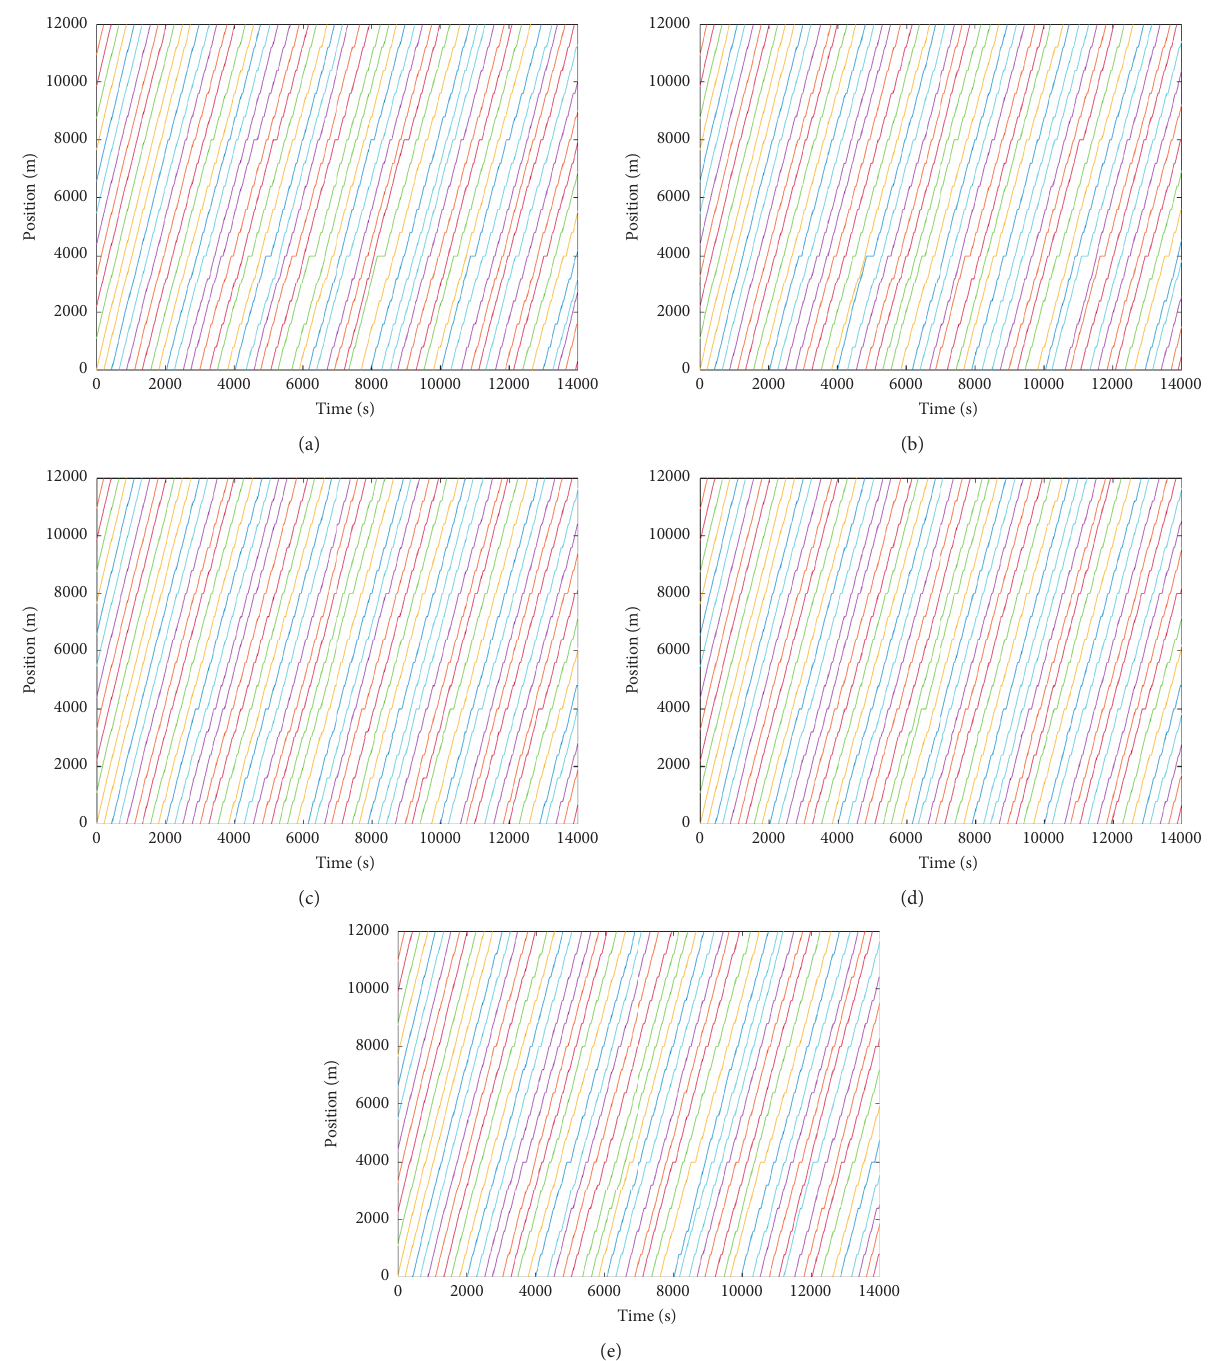
Figure 6: The trajectories of buses under different number of CPS. (a) S1. (b) S3. (c) S4. (d) S7. (e)